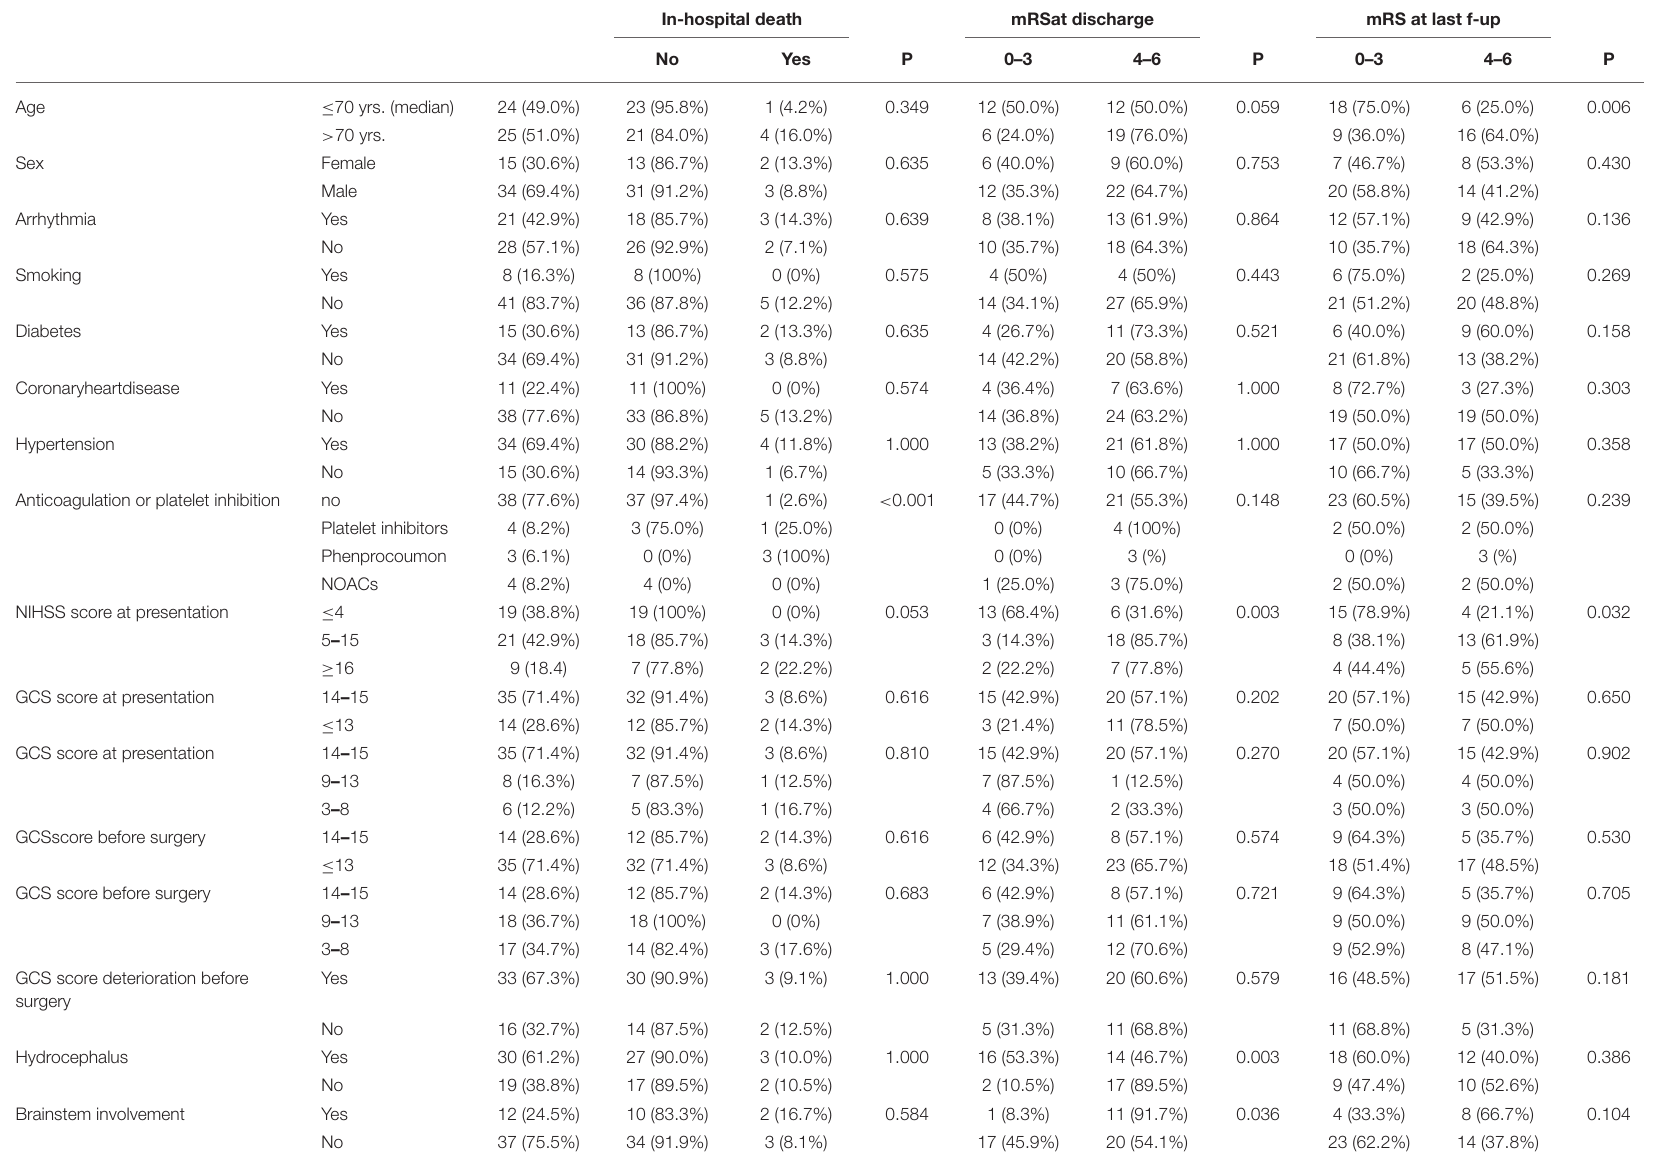
TABLE 4 | Patient, infarct and treatment characteristics as predictors of in-hospital death, and functional outcomes at discharge and last